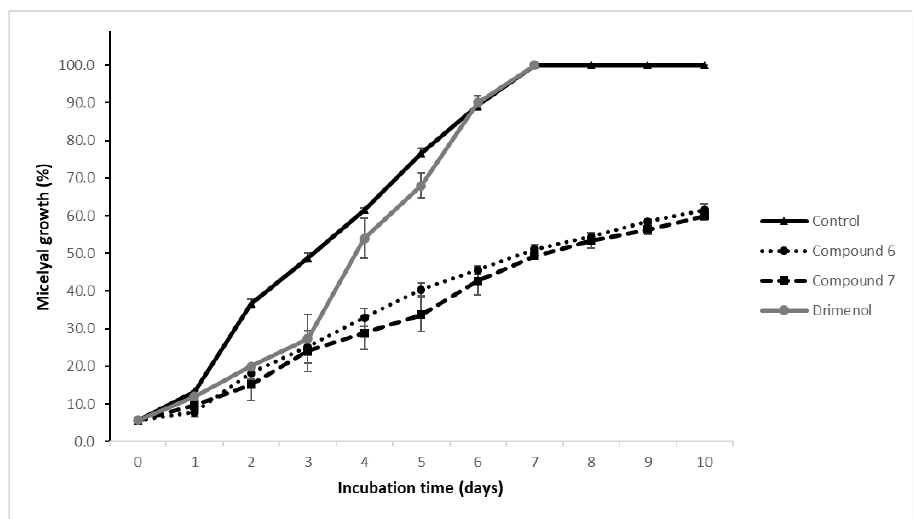
Figure 3. Effect of drimenol, compounds 6 and 7 (0.29 mM) on mycelial growth of B. cinerea . The data correspond to three independent assays in triplicate. The bars correspond to the standard deviation.